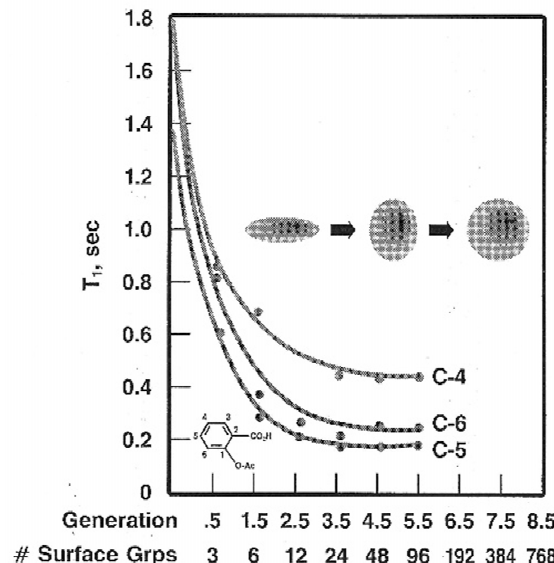
Figure 6. A comparison of spin lattice relaxation times for acetylsalicylic acid carbons (i.e., C-4, -5 and -6) combined with [core:EDA]; dendri -(poly(amidoamine)(-CO 2 Me) Z = 3-96 ; (G0.5-5.5) PAMAM dendrimers as a function of generation and # of surface groups.